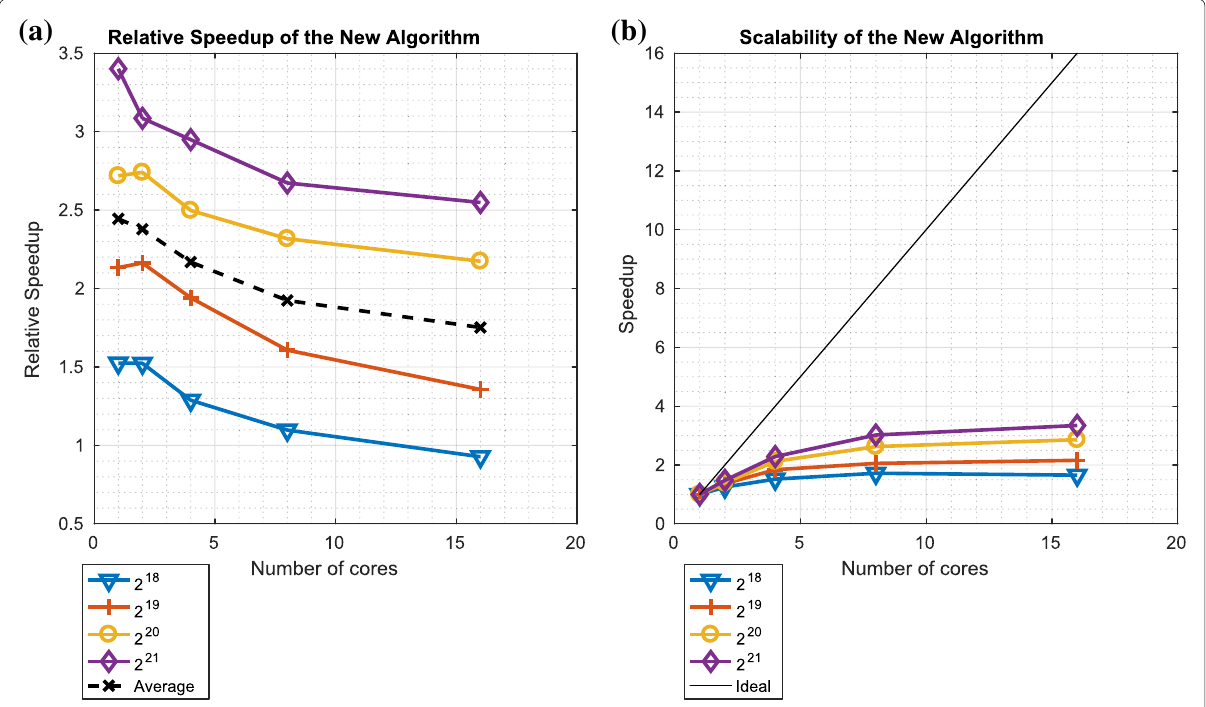
Fig. 14 Relative speedup and scalability of the O (cid:2) (cid:3) N ( log ) 2 O . b Scalability: O 2 N P